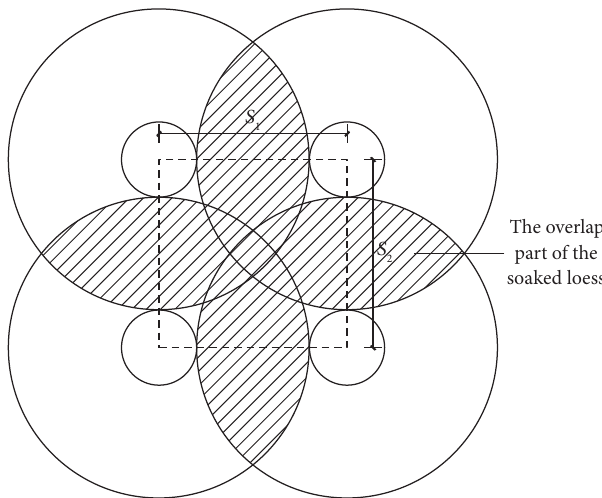
Figure 4: Four water injection holes arranged in a rectangular layout; the horizontal section is at the maximum seepage radius of the immersed loess